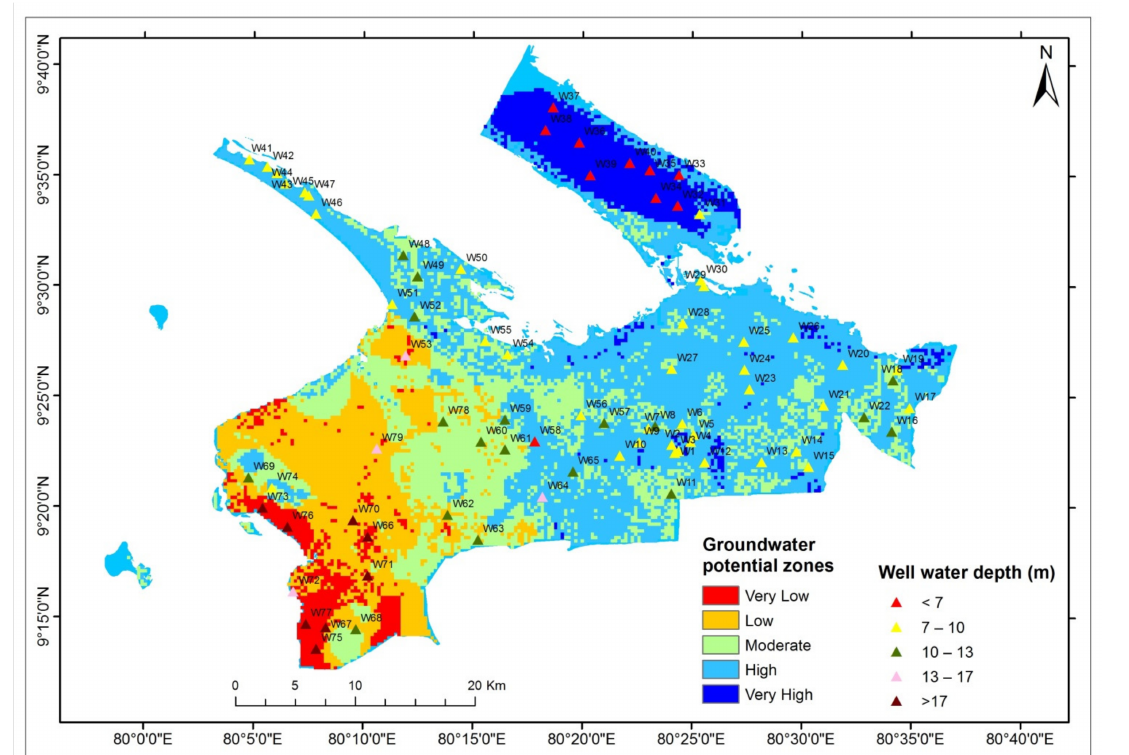
Figure 13. Validation well map of Kilinochchi District.